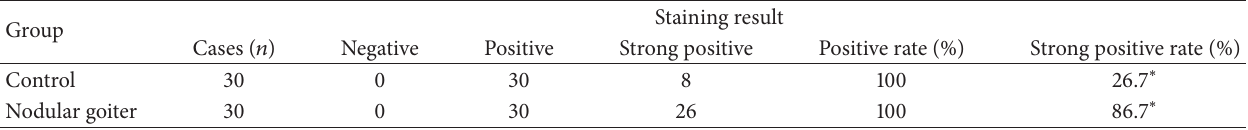
Table 1: Immunohistochemistry detecting TSHR in control and nodular goiter groups.